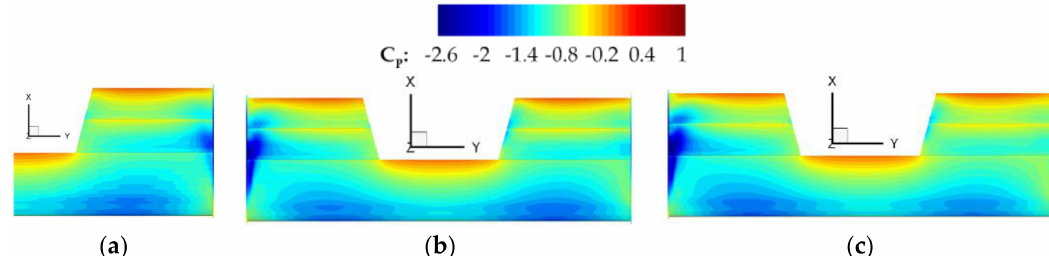
Figure 20. Contours showing the mean pressure coefficient distribution on the pressure surfaces. ( a ) Straight-line Condition; ( b ) Cornering condition; ( c ) Fixed yaw